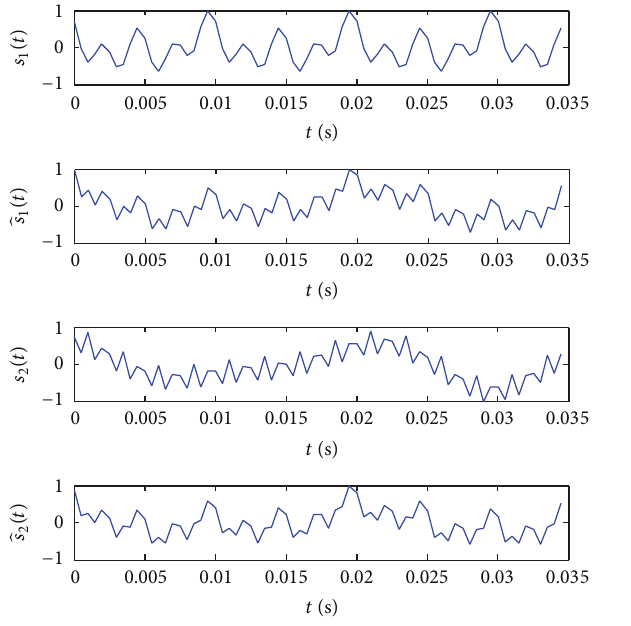
Figure 5: Practical results of fast-ICA ( 𝐿 = 400